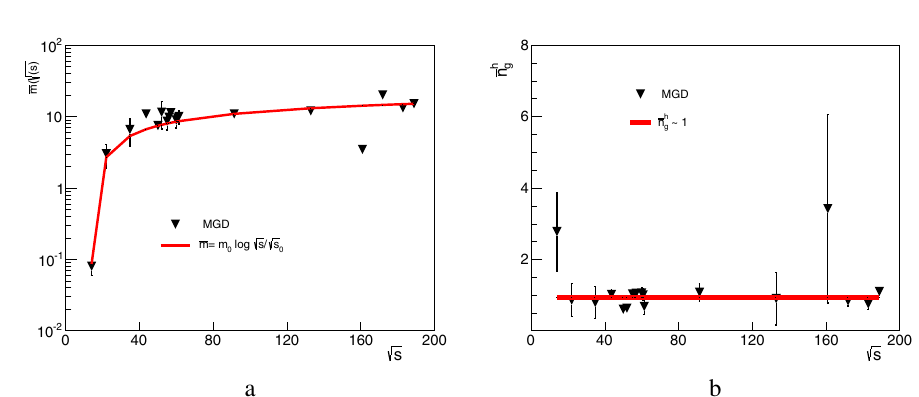
Figure 1. (a) The parameter m , average multiplicity of gluons formed in the qg-cascade from a single gluon. (b) The hadronization parameter n h ([4]) means the average multiplicity of hadrons formed from g single gluon The number of hadrons formed from one gluon during its passing of the second stage. Experimental data for the MD description of hadrons by GDM was taken from about 10 GeV up to 200 GeV